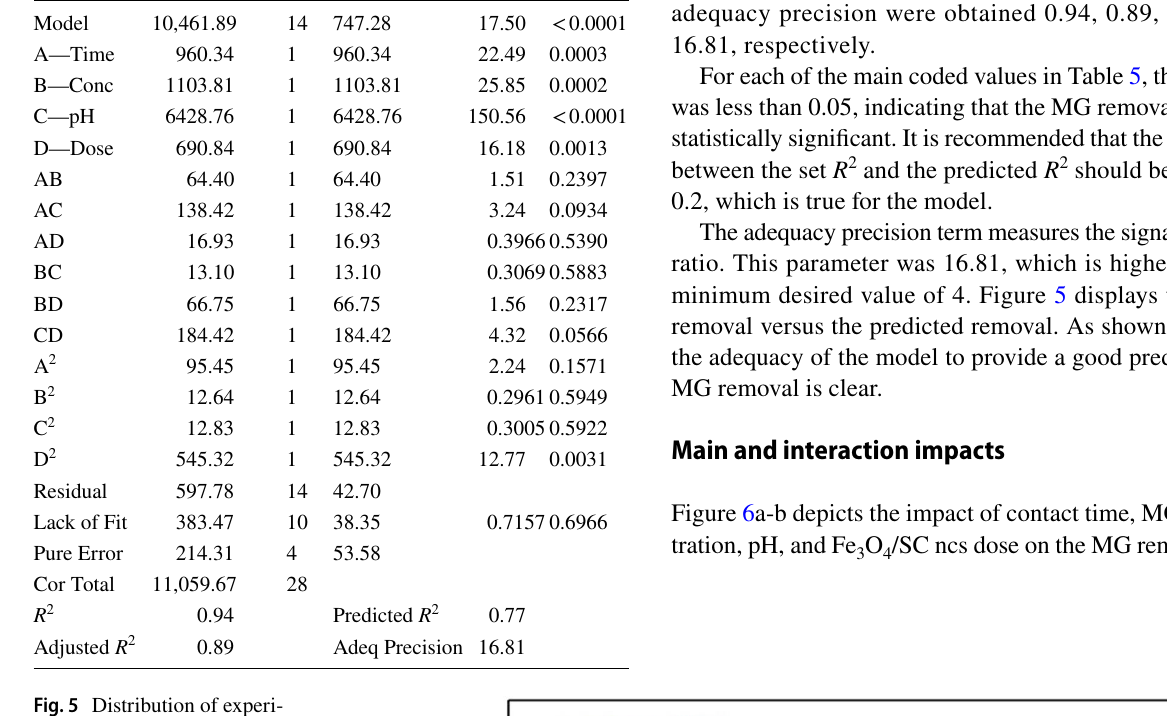
Fig. 5 Distribution of experi- mental vs. predicted removal for MG adsorption onto Fe 3 O 4 / SC